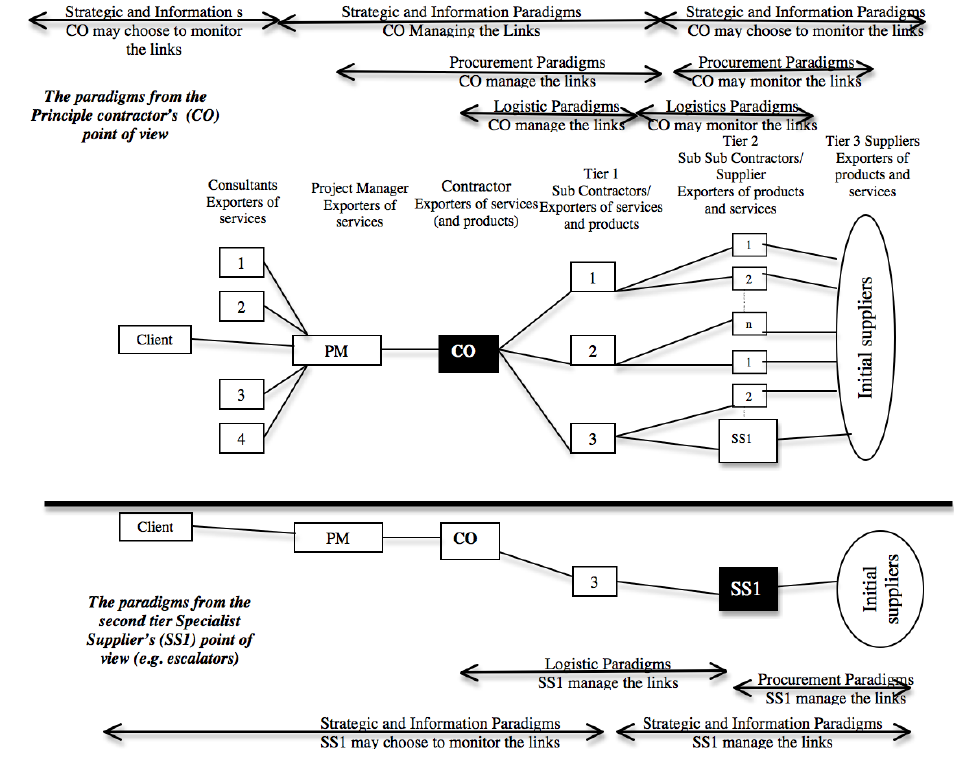
Figure 2 Supply paradigms from a contractor (top) and specialist supplier (bottom)